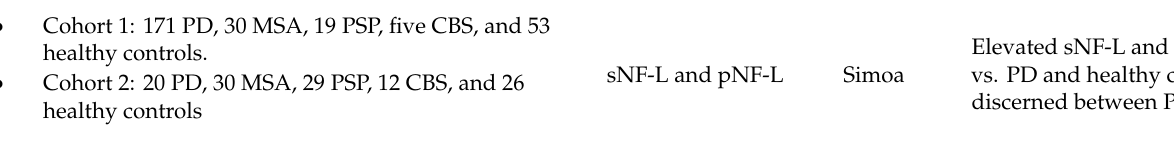
CSF NF-L correlated with 5 year probability of ELISA disease onset, functional capacity, and total motor score CSF and pNF-L were increased in premanifest and manifest HD patients vs. controls. Manifest HD ELISA displayed higher levels vs. premanifest